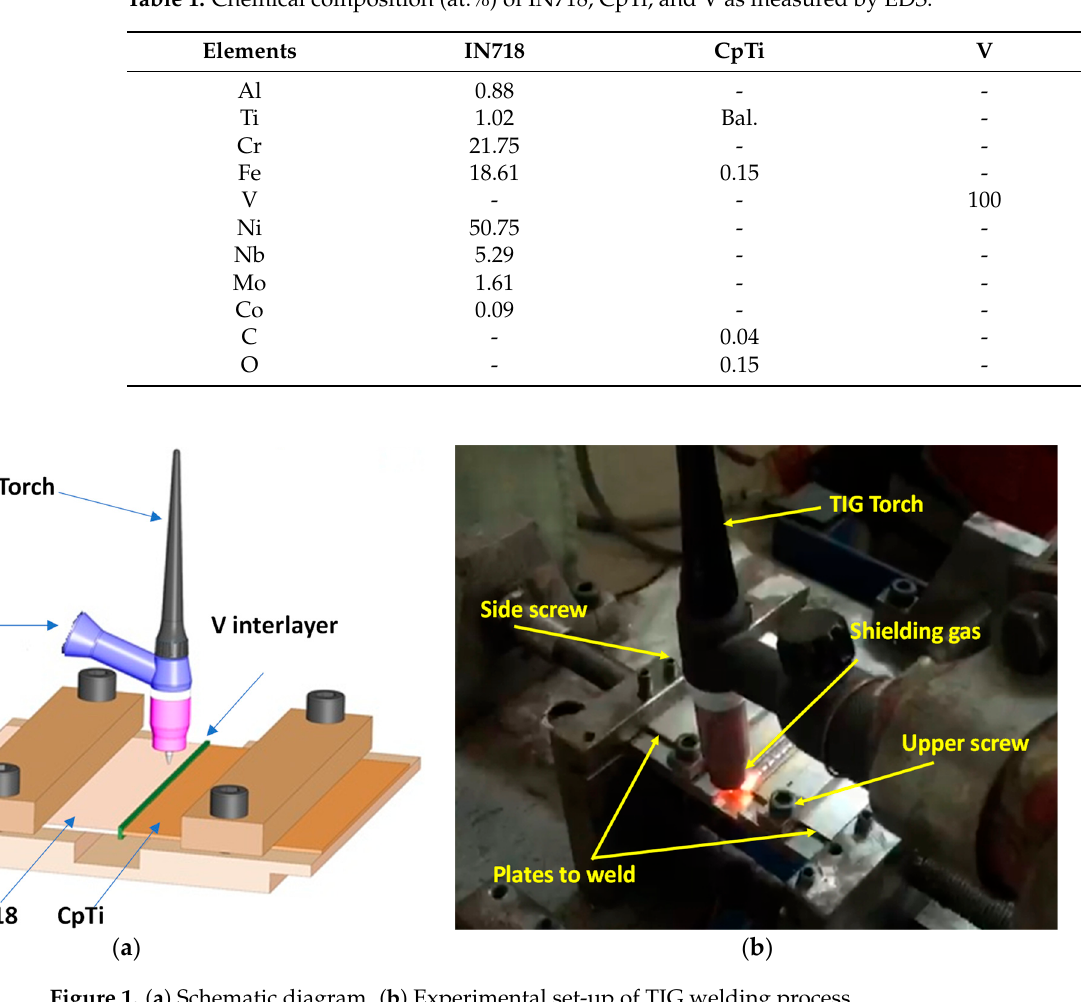
Table 1. Chemical composition (at.%) of IN718, CpTi, and V as measured by EDS.